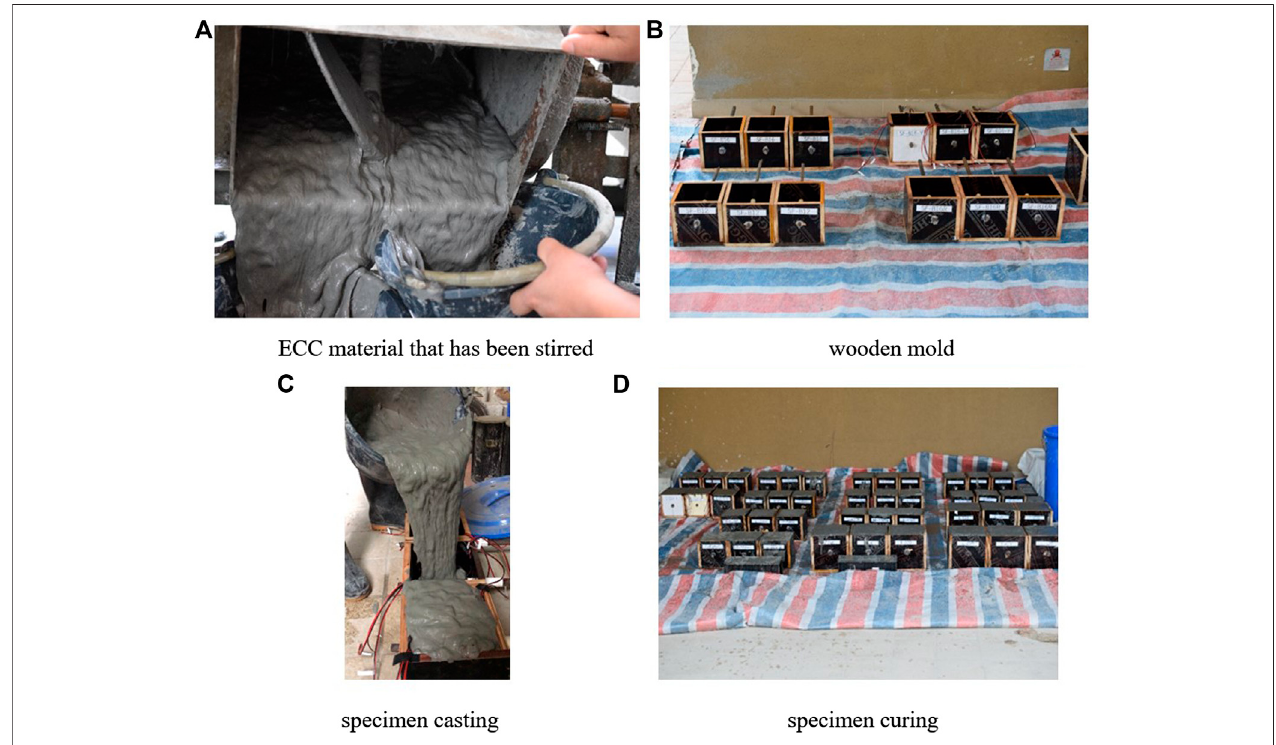
FIGURE 4 | Production process of ECC specimens.